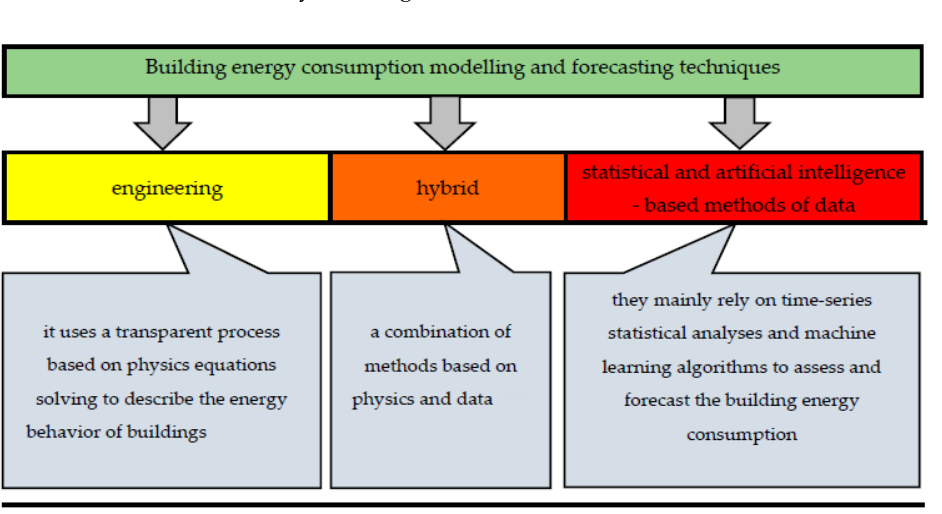
Figure 1. Classification of methods for forecasting energy consumption in buildings [7 – 36].